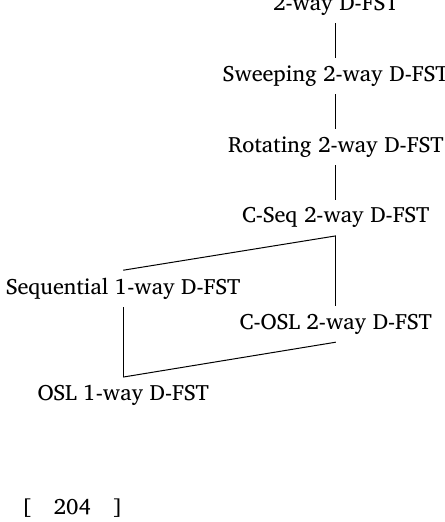
Hierarchy of subclasses for 2-way FSTs